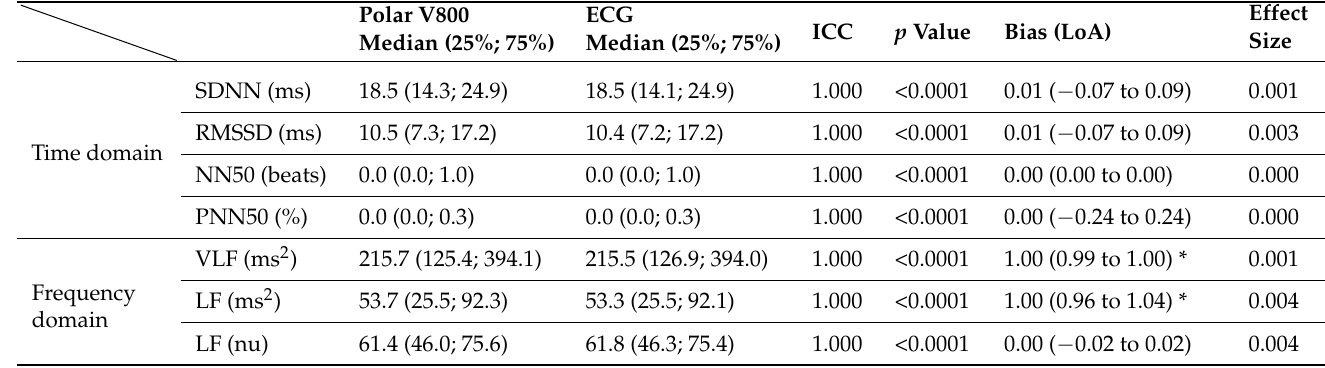
Table 6. HRV parameters for